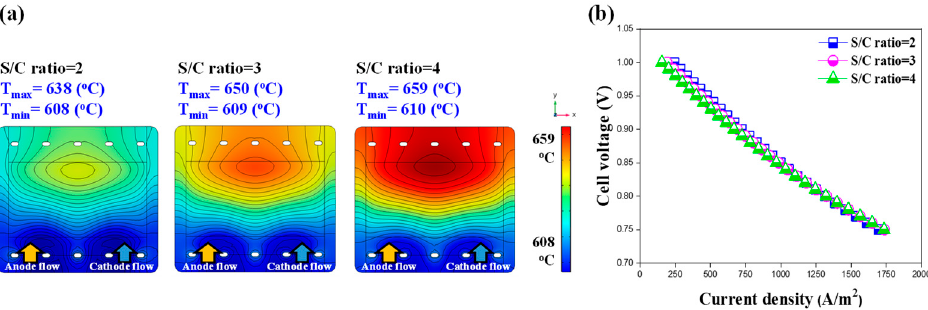
Figure 14. ( a ) Temperature distribution and ( b ) i–V curve according to the S/C ratio, considering the electrochemical reaction.